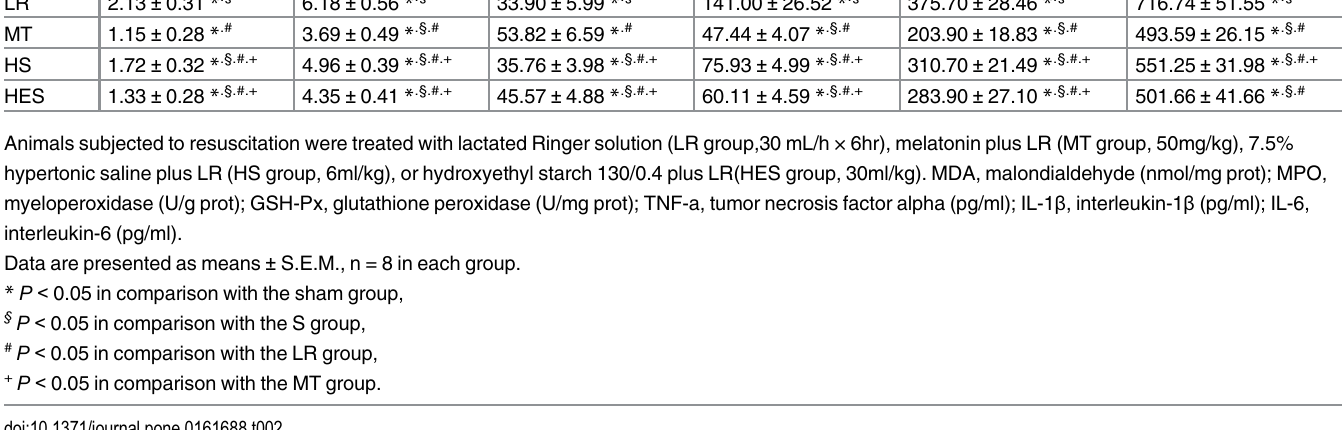
group animals (p < 0.01). No statistical differences were observed in the HS group and HES group in comparison with LR group (p > 0.05). The MT group had a significant increase com- pared with the HS group(p < 0.05). As shown in Fig 8C, hemorrhage (shock group) resulted in a decrease in occludin compared with the sham group (p < 0.01). Occludin expression decreased more significantly after LR resuscitation compared with the shock group (p < 0.001). In MT group (p < 0.001) and HES group (p < 0.05), intestinal levels of occludin were significantly increased compared with LR group. No statistical difference was observed in the HS group and LR group (p > 0.05). But the MT group had a significant increase compared with the HS group(p < 0.05) and HES group (p < 0.05).